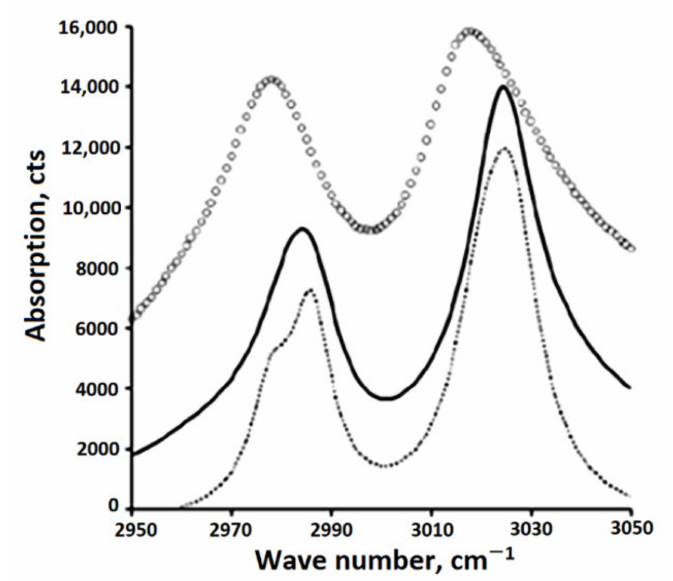
Figure 10. CH peaks of IR absorption of the experimental spectra of the maximally stretched (empty circles), initial (solid line) PVDF films and model simulation of a fragment of the spectrum of the initial film (dotted line).